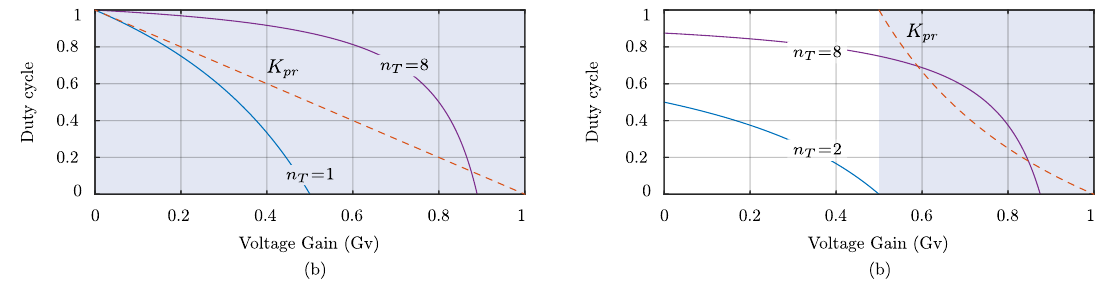
Figure 7. Operation of the step-down PPC in terms of the transformer turns ratio n T and the voltage gain G v . ( a ) Step-down PPC dc-link side connected; ( b ) Step-down PPC PV-side